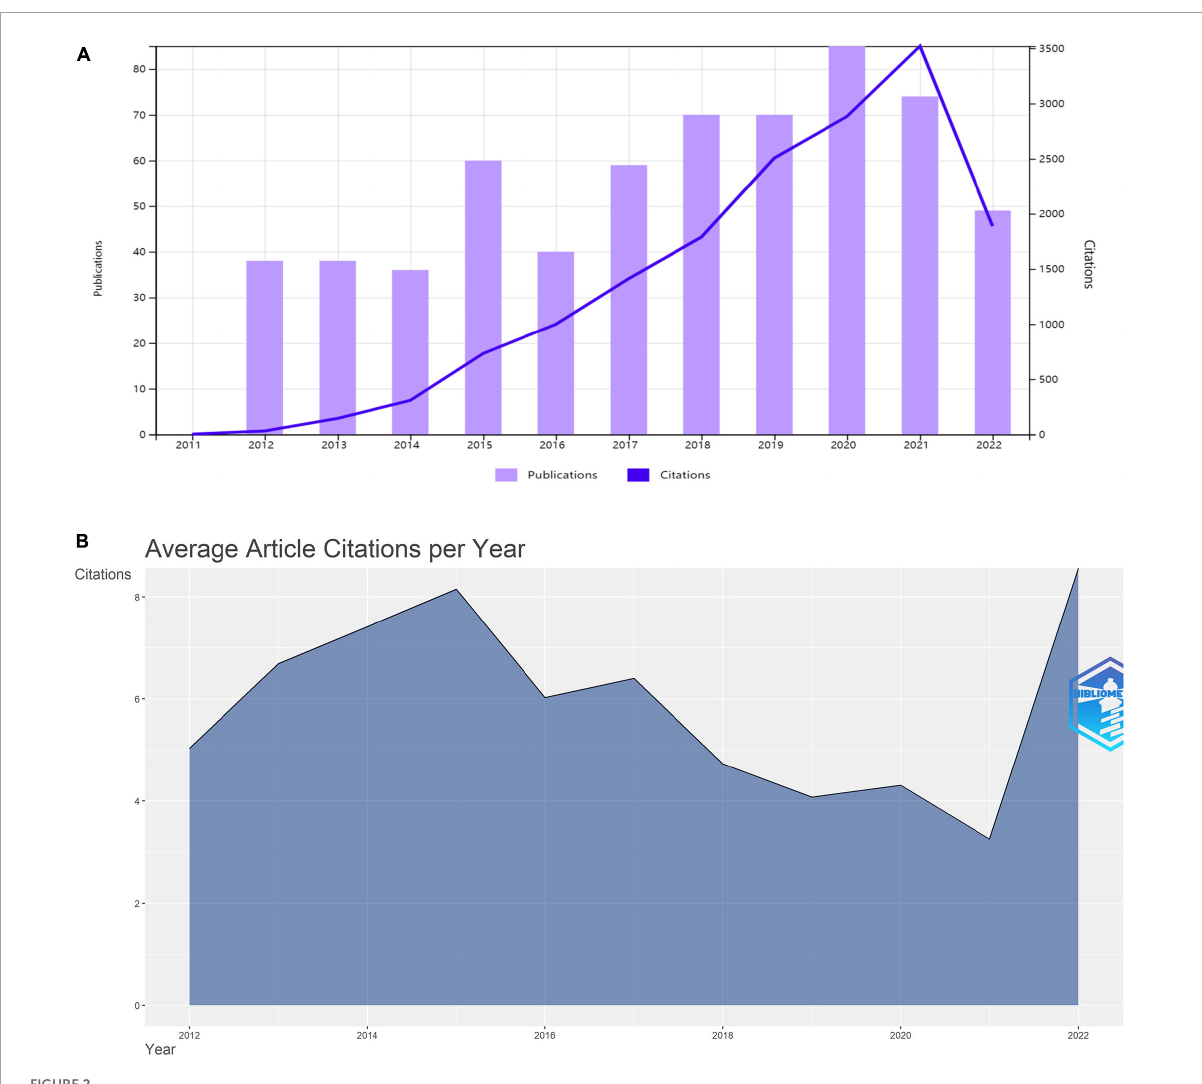
FIGURE2 Trends in the overall quantity and average number of citations to articles per year from 2012 to 2022. (A) Trends in the overall quantity. (B) Average number of article